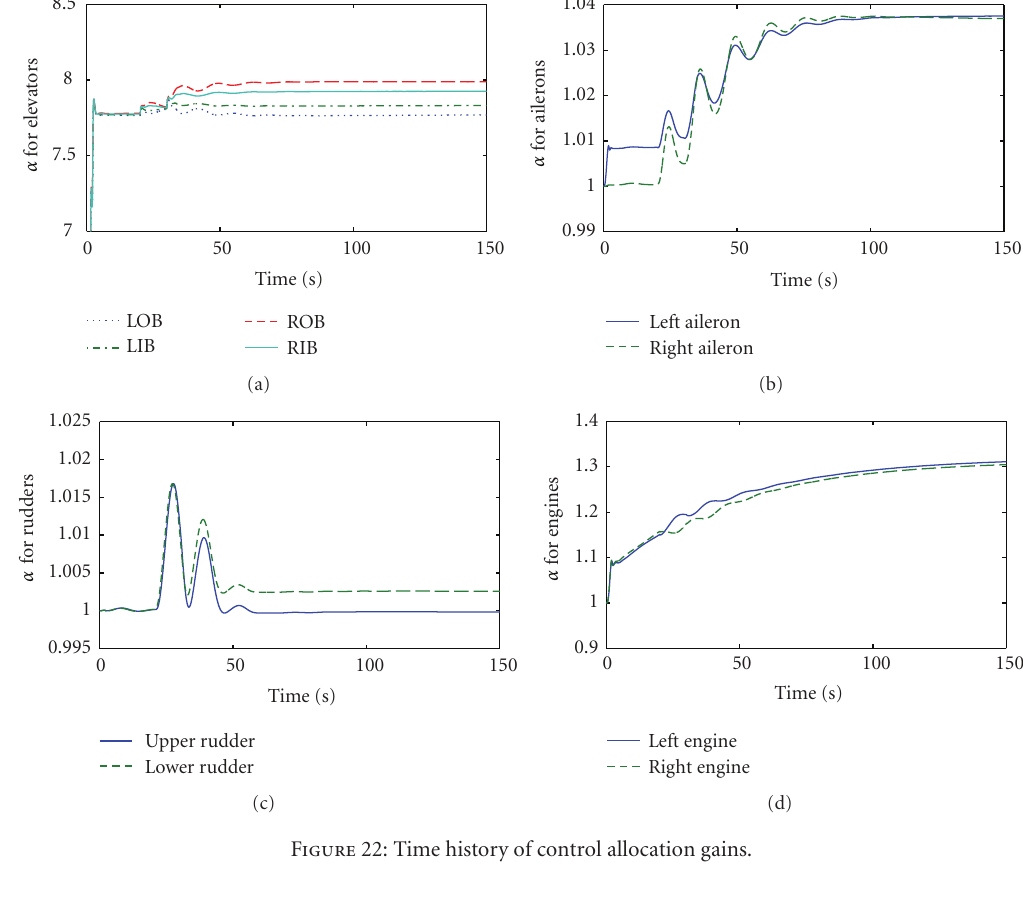
Figure 22: Time history of control allocation gains.